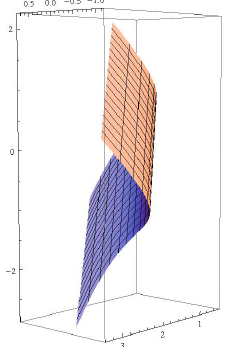
Figure 2. GNS for κ = 0.